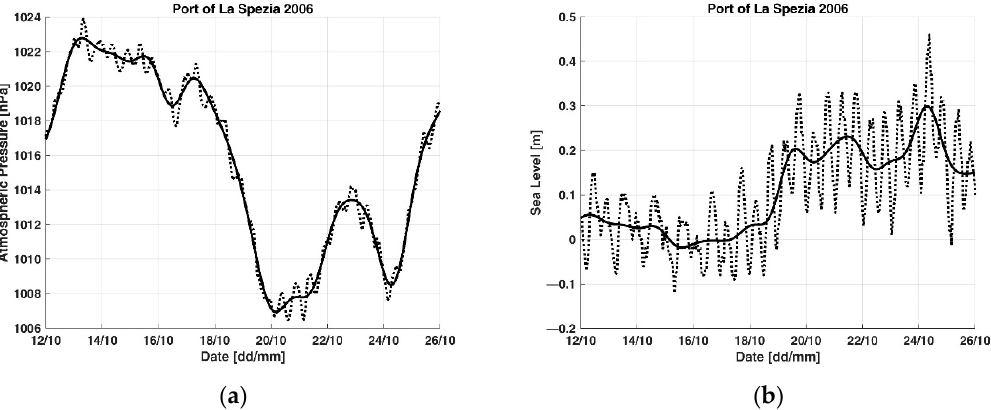
Figure A3. Measurements carried out between 12 and 26 October 2006 inside the port of La Spezia: